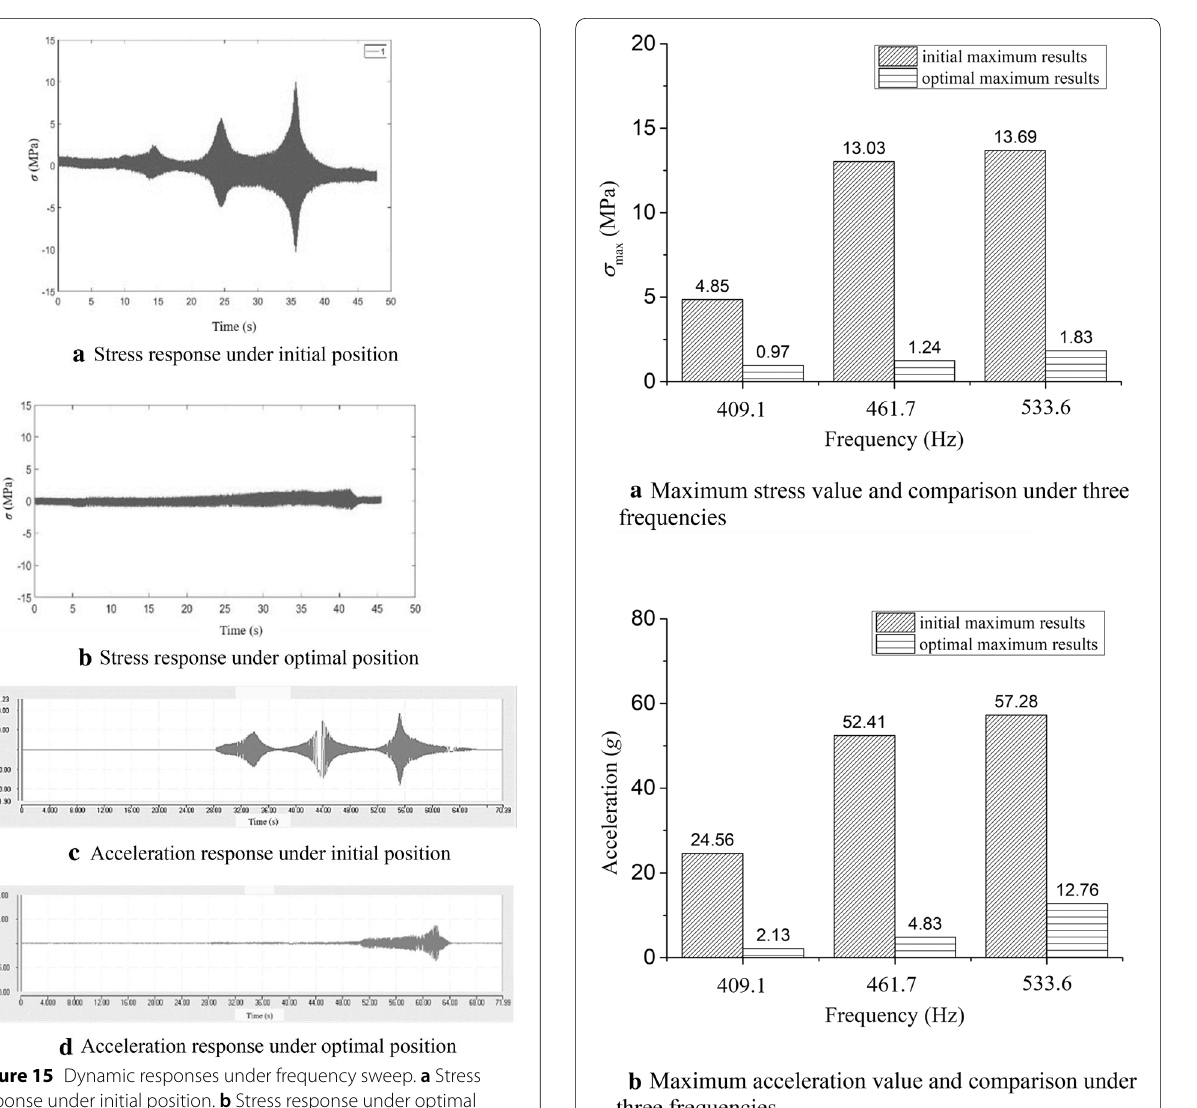
Figure 16 Comparison of optimization results. a Maximum stress value and comparison under three frequencies. b Maximum acceleration value and comparison under three